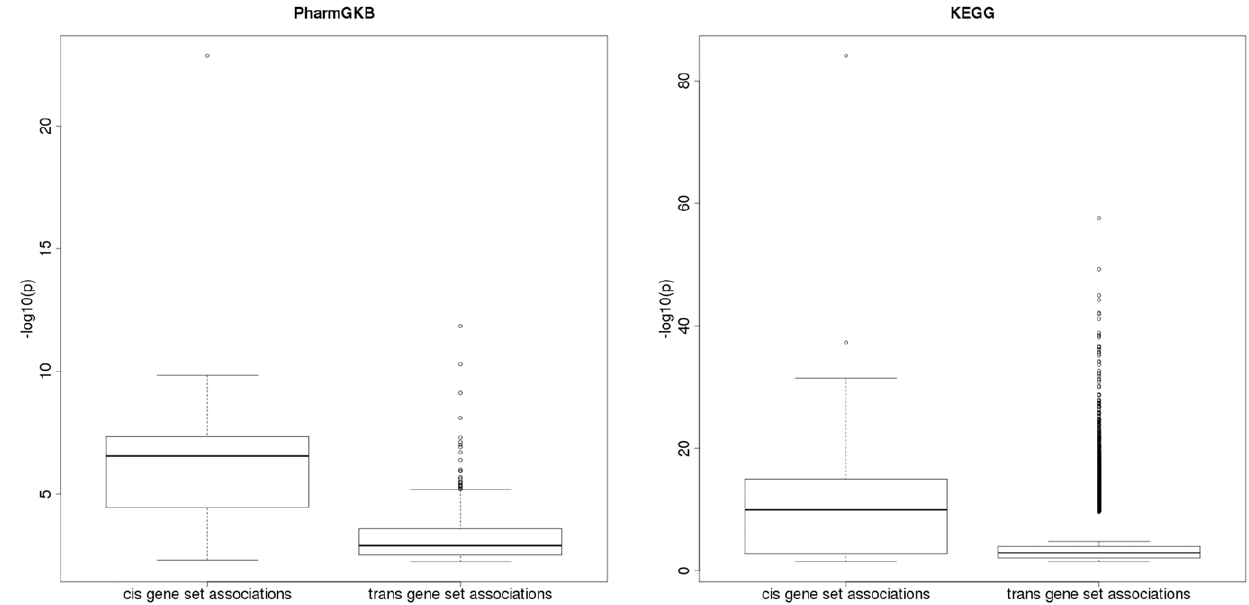
Figure 5. Boxplots of log transformed p-values for cis - and trans -GS association results. (A) PharmGKB and (B) KEGG.